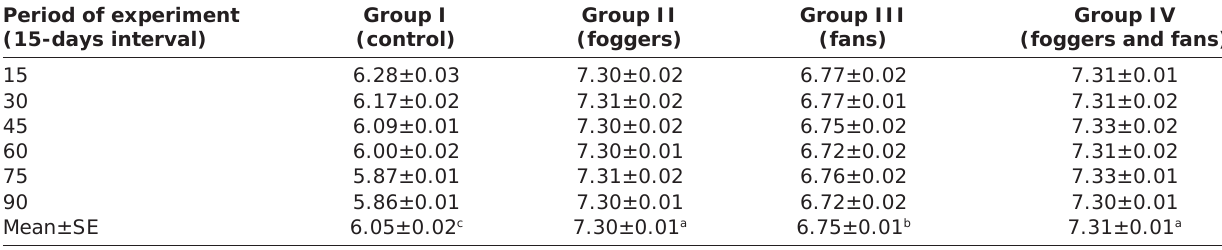
Table-9: Effect of microclimate alteration on milk yield (kg) in Murrah buffaloes during summer. Period of experiment (15-days